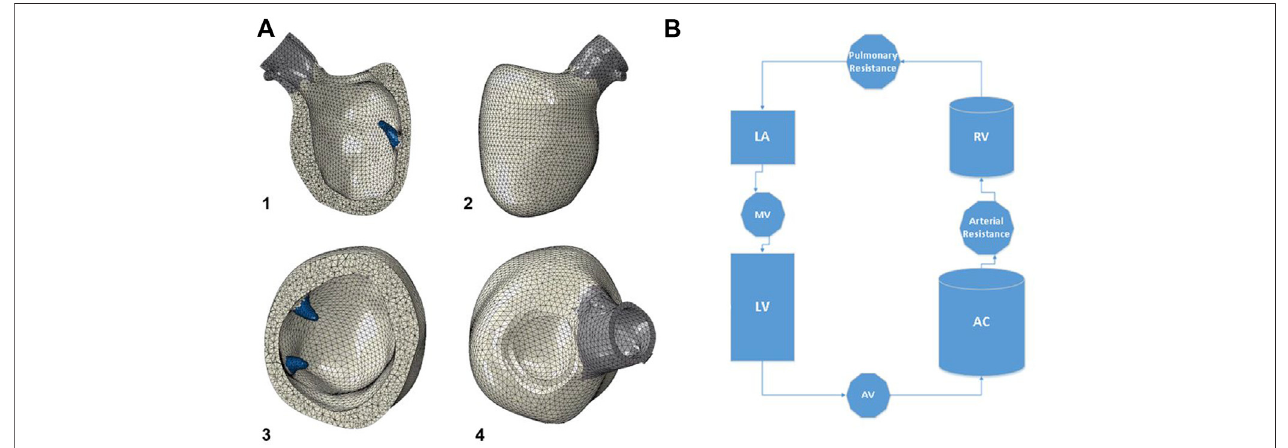
FIGURE2|(A) Themodelgeometryisthenmeshed,withtheleftventricleconsistingof91,000ten-nodedtetrahedralelements.Thepapillarymusclesareshownin blue,andwereexcludedfrombiomechanicalanalysisoftheleftventricle.1)anteriorcutaway,2)shortaxiscutaway,3)posteriorview,4)superiorview. (B) Diagramofthe circulatory model connected to the left ventricle for cardiac cycle simulations. Valves are assigned resistance values, and chambers are assigned elastances. LV: left ventricle, AV: aortic valve, AC: arterial chamber, RV: right ventricle, LA: left atrium, MV: mitral valve.